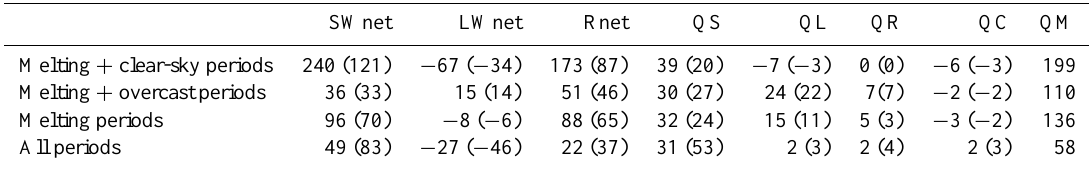
Melting conditions are selected as periods where QM>0 in SEBmr.